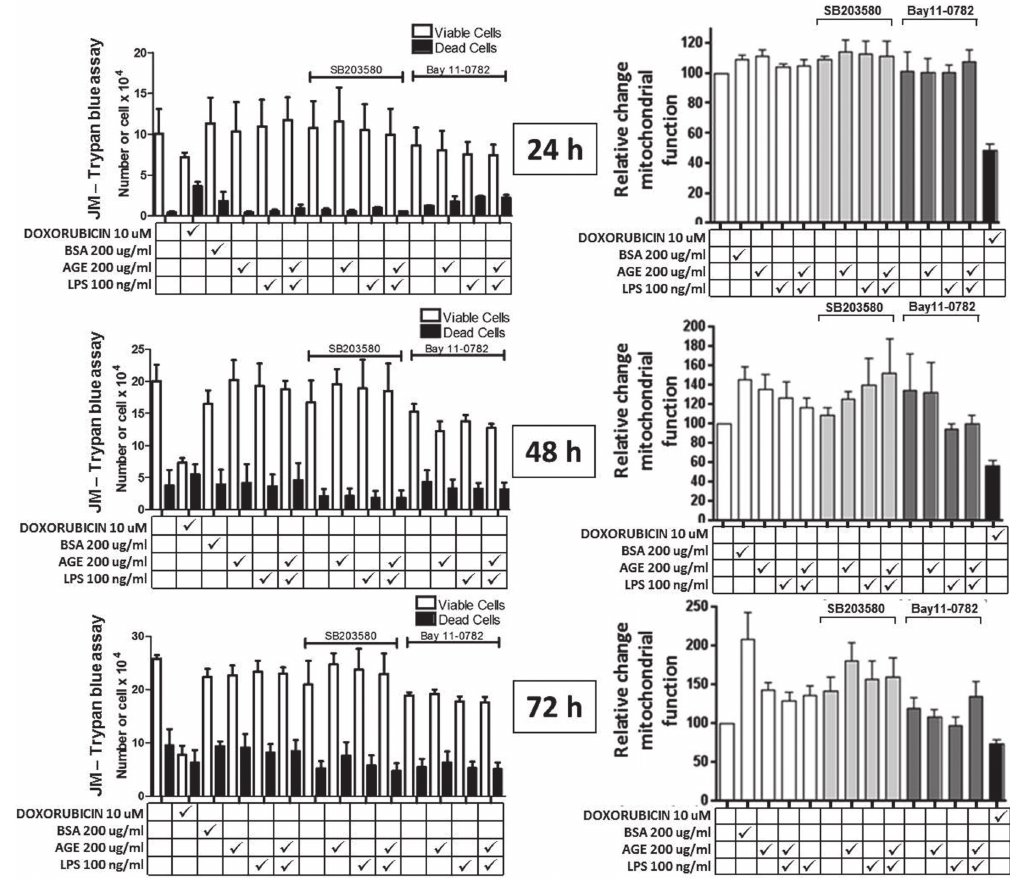
Figure 1- Modulation of cell death in the JM (lymphocyte) cell lineage. Right column corresponds to Trypan Blue Test, and Left column to MTS assay. The cell line was stimulated for 24, 48 and 72 hours with E. coli LPS (100 ng/mL) with or without AGE-BSA (200 µg/mL) in the presence and absence of p38 MAPK inhibitors (SB203580, 10 µM) and NF-kB (Bay 11-7082, 10 µM). Bars indicate mean±standard deviation of three independent